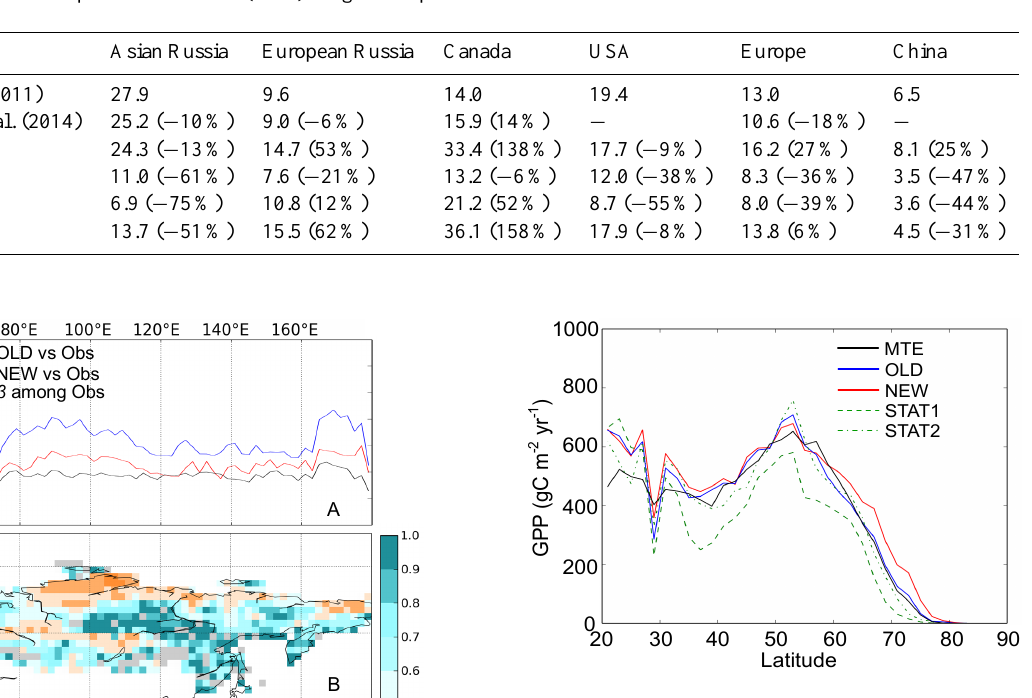
Figure 10. Latitudinal mean annual GPP (2 ◦ bands) during 1999– 2008 from OLD (blue) and NEW (red), compared with that from STAT (static run in which ORC-VD is deactivated, green dashed lines) and MTE (Jung et al., 2011; black). In STAT1 and STAT2, the PFT map is prescribed from ESA and SYNMAP,